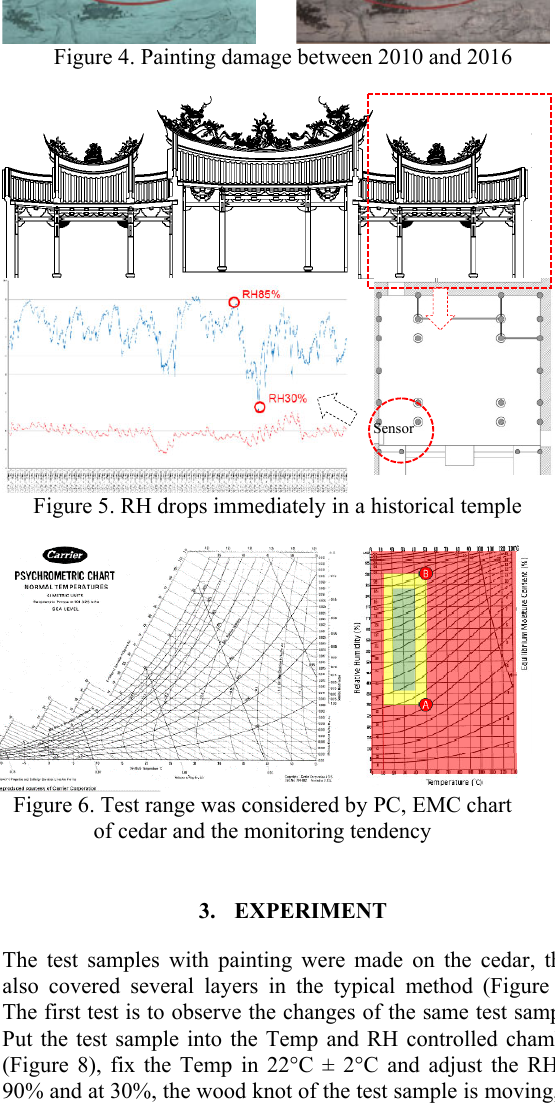
Figure 3. Different layer of the painting on the wood